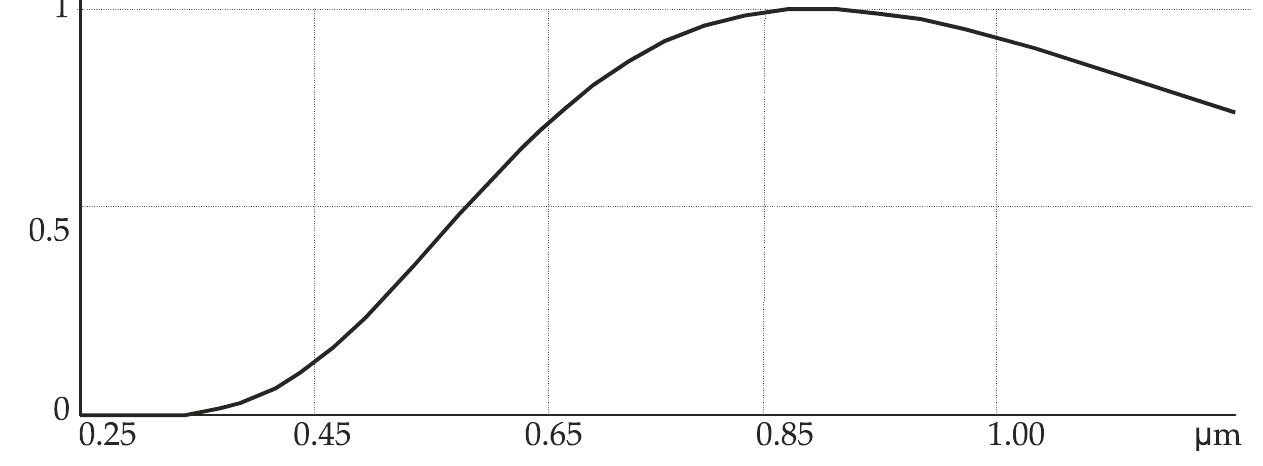
Figure 7. Matrix-displayed diffraction orders for wavelengths of 455 nm and 750 nm for ( a ) a single point source and ( b ) a line-arranged group of point sources.